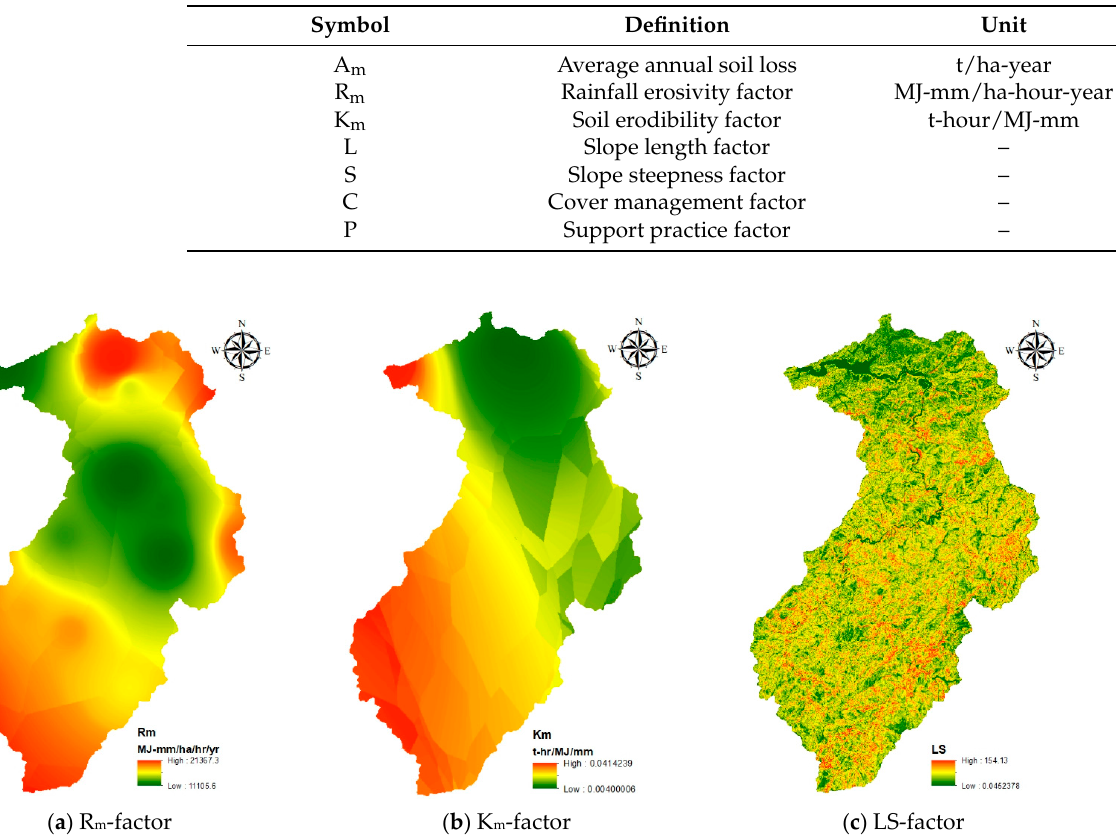
Figure 4. The distribution maps of R m -, K m -, and LS-factors. Table 6. The USLE factors and their definitions and units.